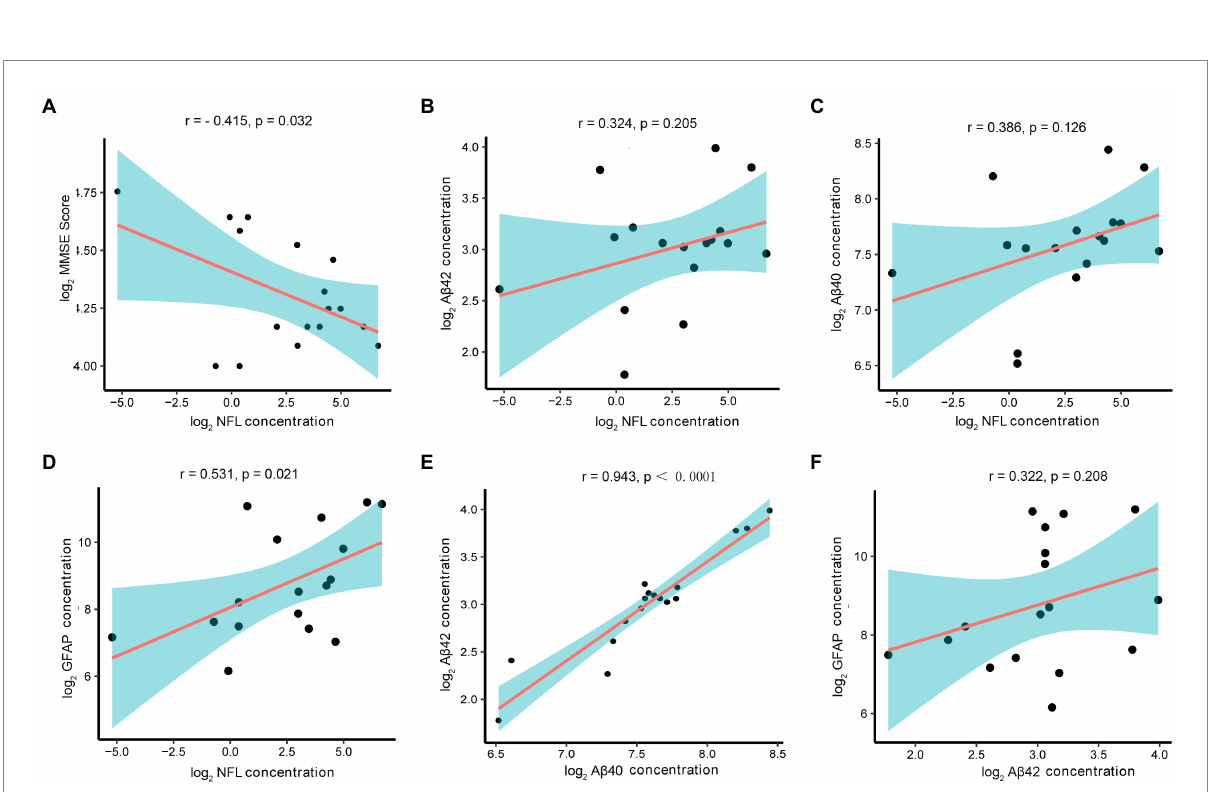
FIGURE 3 Correlation of AD-related biomarkers concentrations with MMSE scores in the cataract group. Note: The AD-related biomarkers concentrations and MMSE scores were log-transformed. p < 0.05 was considered statistically significant. The blue area represented the 95% confidence interval. (A) Lower MMSE scores correlated with higher AH levels of NfL( r = − 0.415, p = 0.032). (B–D) The NfL concentration showed a mild positively correlation with the concentrations of A β 42 ( r = 0.324, p = 0.205), A β 40 ( r = 0.386, p = 0.126), and GFAP ( r = 0.531, p = 0.021). (E) The A β 40 and A β 42 concentrations showed a strong positive correlation ( r = 0.943, p < 0.0001). (F) Although it has not reached statistical significance, there was a correlation between the concentrations of A β 42 and GFAP ( r = 0.322, p =